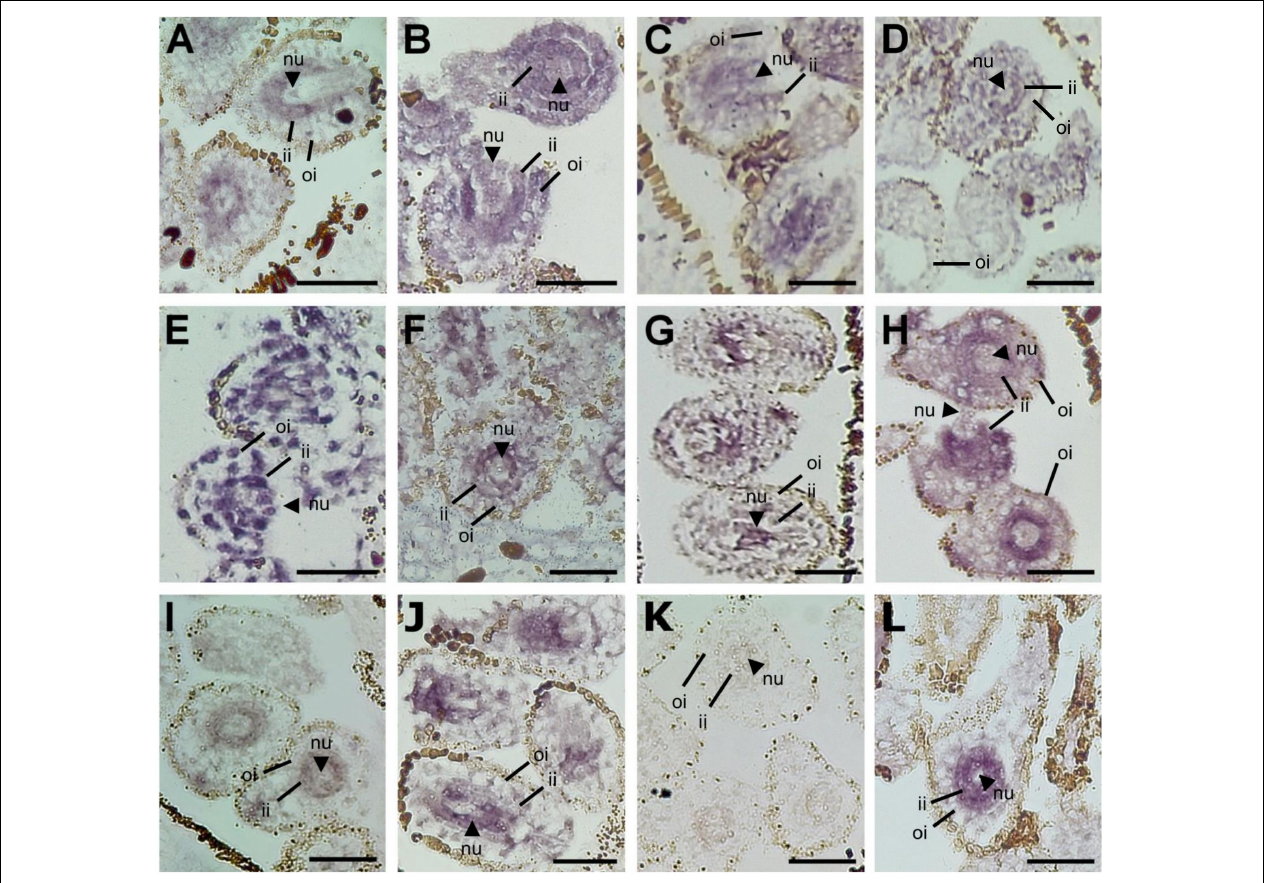
FIGURE 5 | In situ RNA hybridization experiments in pistils collected from sexual and aposporous apomictic accessions. (A,C,E,G,I,K) Sexual genotypes; (B,D,F,G,J,L) aposporous apomict genotypes. (A,B) HpIDN2 ; (C,D) HpFDM2 ; (E,F) HpFDM4 ; (G,H) HpRDR16 ; (I,J) HpLSD1 ; (K,L) HpTIL1 . Experiments were performed with the antisense probes, to hybridize mRNAs in sense orientation. The hybridization signal is indicated with the blue color. nu: nucellus; ii: internal integuments; oi: outer integuments. Scale bar: 50